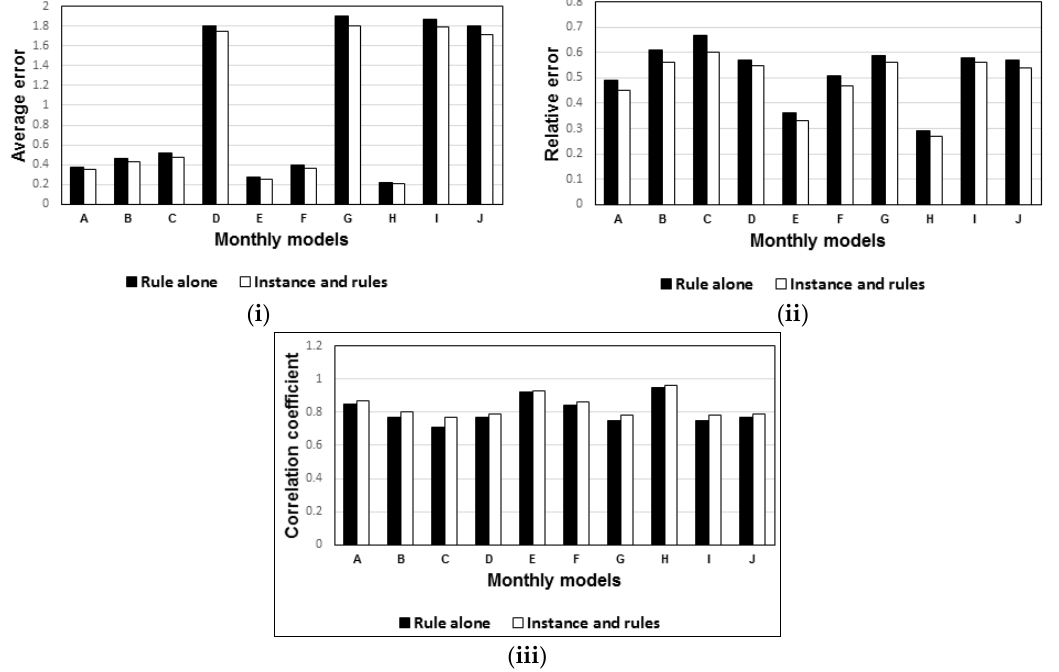
Figure 4. Model performance evaluation: ( i ) MAD; ( ii ) relative error; ( iii ) correlation coefficient for the 10 monthly models; (A) June one-month outlook, (B) June two-month outlook, (C) June three-month outlook, (D) June four-month outlook, (E) July one-month outlook, (F) July two-month outlook, (G) July three-month outlook, (H) August one-month outlook, (I) August two-month